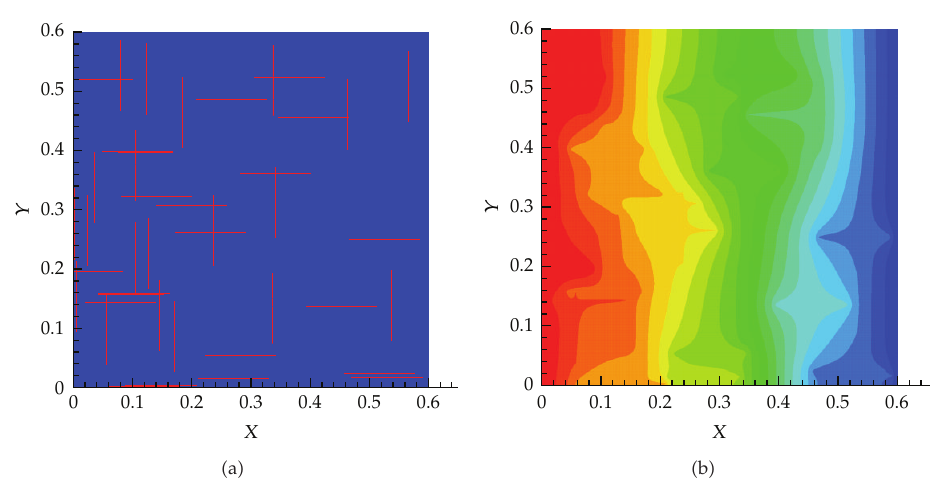
Figure 9: Fractures orientations (cid:2) 40 fractures (cid:3) and pressure contours based on the fine